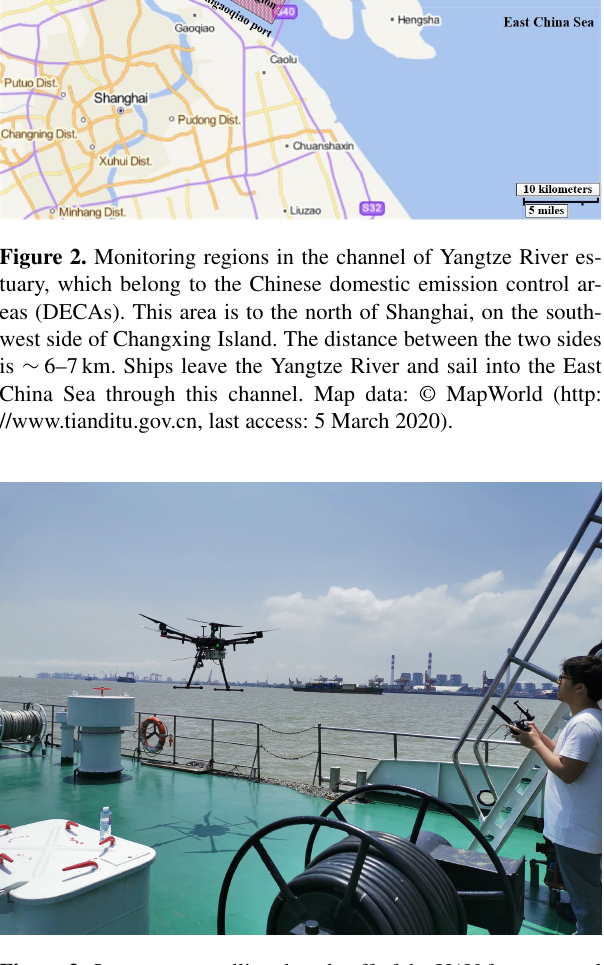
Figure 3. Operator controlling the takeoff of the UAV from a patrol